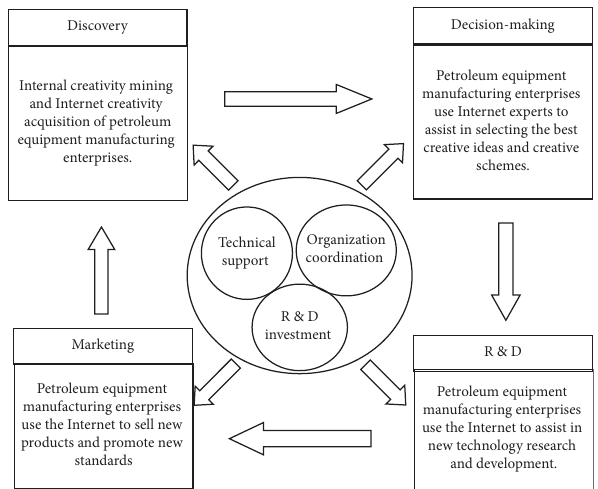
Figure 1: Breakthrough technology innovation process of petro- leum equipment manufacturing